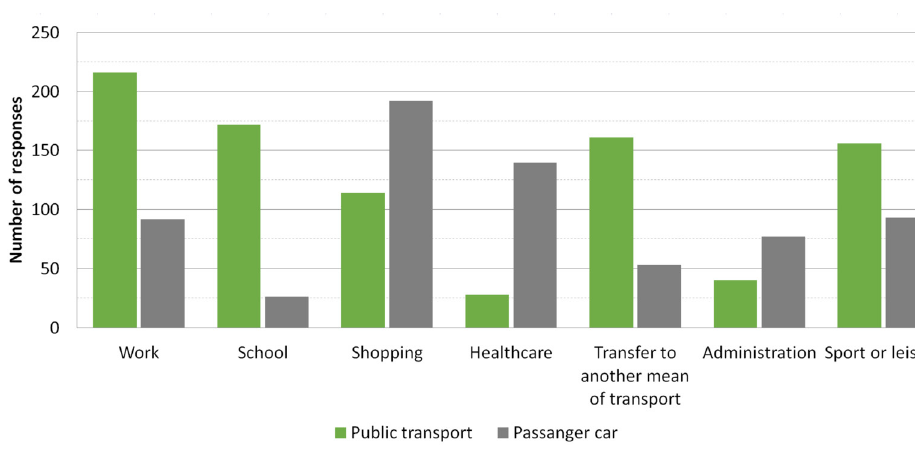
Fig. 7. Survey results chart of responses to the question What is your main purpose of travel by public transport, and which by car